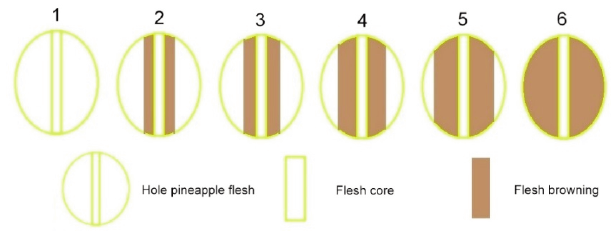
Fig. 1 ­ Scheme of the score classification used to determine the internal browning severity in the experiment during each observation. Score: 1 (0%), 2 (20%), 3 (40%), 4 (60%), 5 (80%), and 6